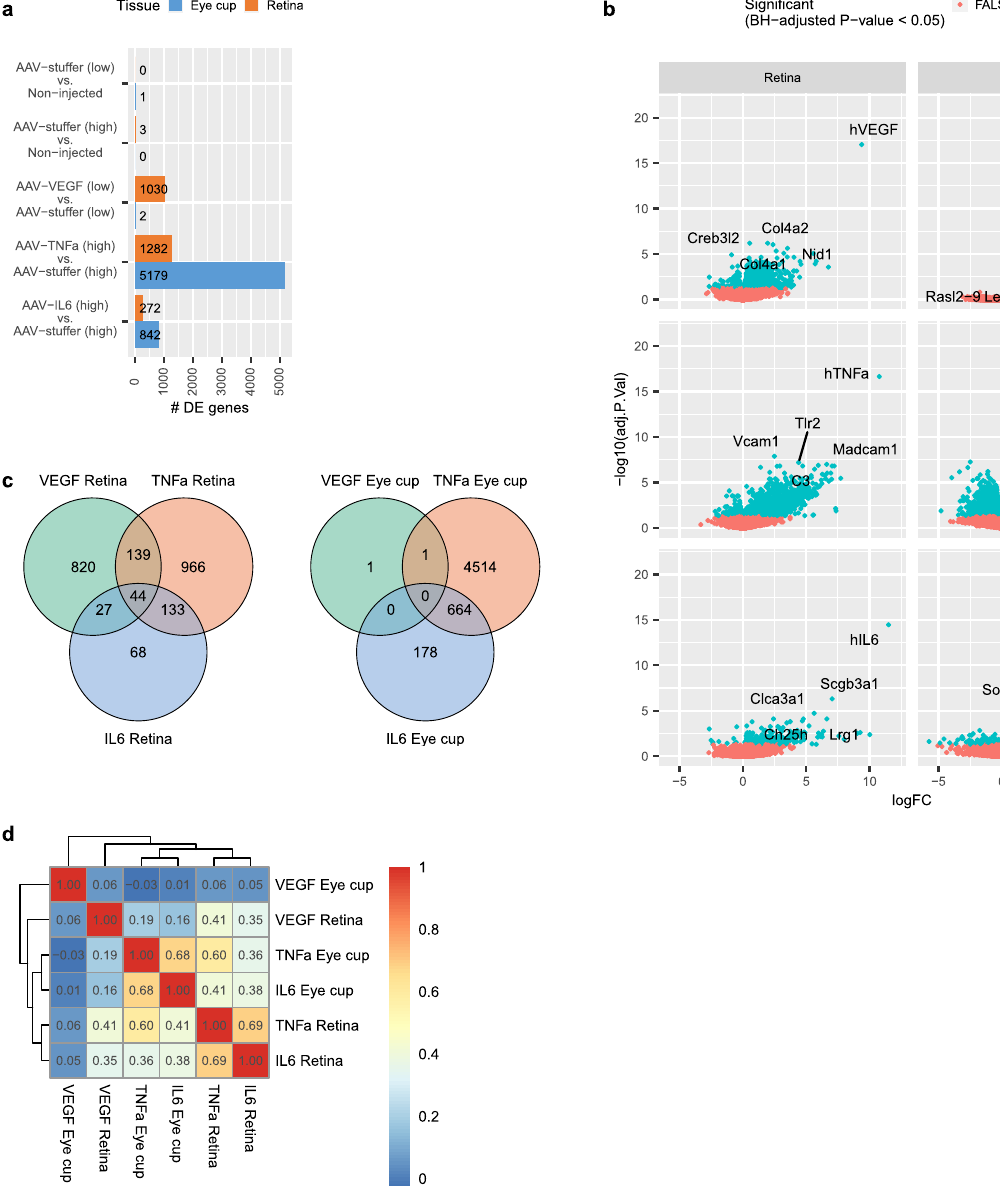
respective controls (BH-adjusted p-value < 0.05). ( b ) Volcano plots indicating top differentially regulated genes in retina and eye cup tissue upon injection with AAV-VEGF, AAV-TNF-α, or AAV-IL-6. ( c ) Venn diagrams representing sets of differentially expressed genes overlapping between treatment groups. 820 genes were specifically regulated by AAV-VEGF. Large overlap between TNF-α and IL-6-induced differentially regulated genes in both retina and eye cup tissue. ( d ) Spearman correlation verified a strong correlation between TNF-α and IL-6-induced gene expression changes in both retina and eye cup tissue. Dendogram shows hierarchical clustering and therefore similarity of treatment induced fold-changes compared to their respective